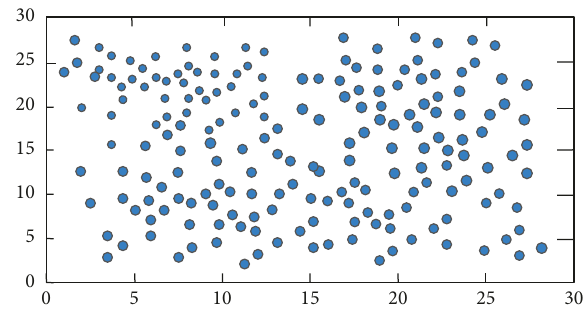
Figure 3: Randomly generated two-dimensional plane point